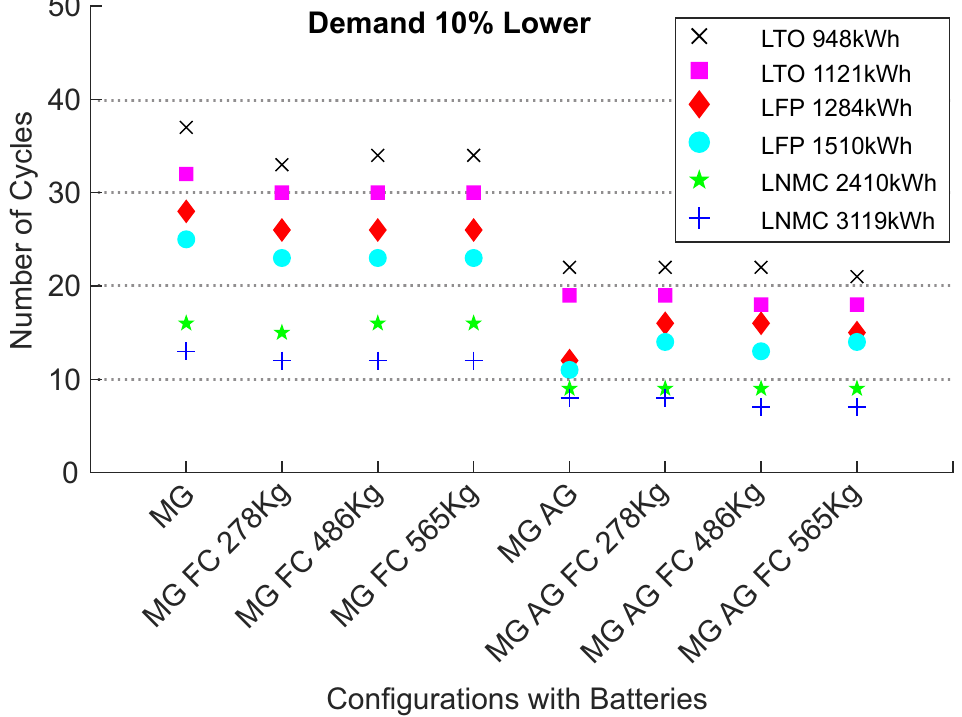
Figure 9. Number of cycles that each battery required in each configuration for a 10% lower